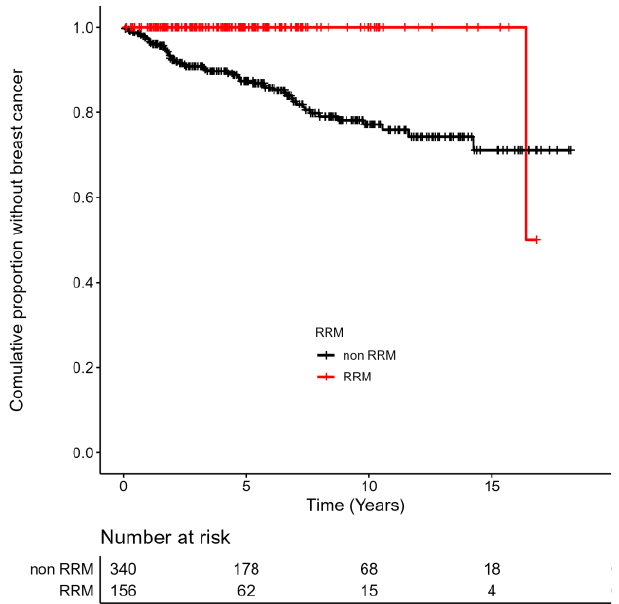
Figure 2. Incidence of Breast Cancer (BC) in BRCA1/2 Carriers With and Without RRM (Kaplan-Meier Curves): In the cohort of BRCA1/2 carriers with RRM, the time was calculated from the RRM till the occurrence of BC or the end of the study in 2020. In the cohort of BRCA1/2 carriers without RRM, the time was calculated from the initiation of surveillance of the woman till the occurrence of BC or the end of the study in 2020. The term “complete” represents BRCA1/2 carriers with diagnosed BC. The term "censored" represents the BRCA1/2 carriers without BC. RRM—risk-reducing mastectomy. A significant result was achieved, HR 20.18, Log-Rank test, p <